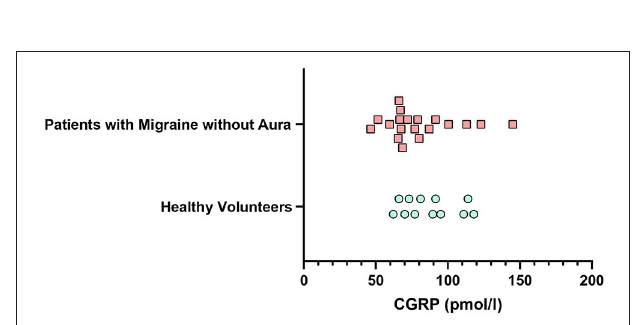
FIGURE 4 | Mean plasma concentration of CGRP at the baseline in healthy individuals and patients with migraine ( p = 0.232).